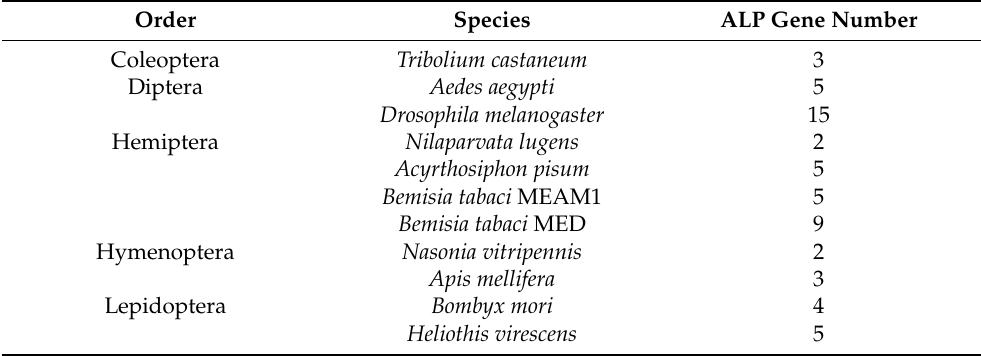
Table 1. Alkaline phosphatase (ALP) genes identified in Bemisia tabaci MEAM1 and MED and nine other insects.